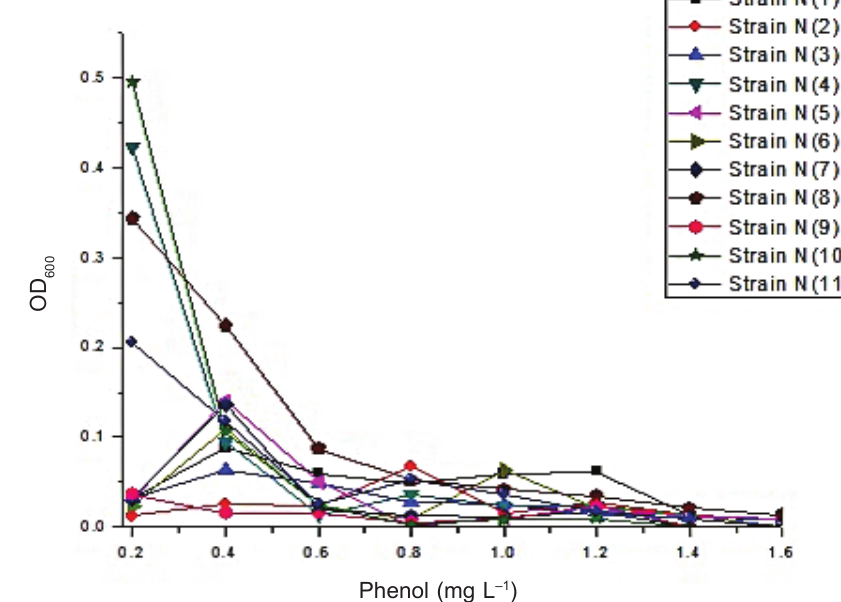
Fig. 1 – OD value of different microorganisms in the phenol medium